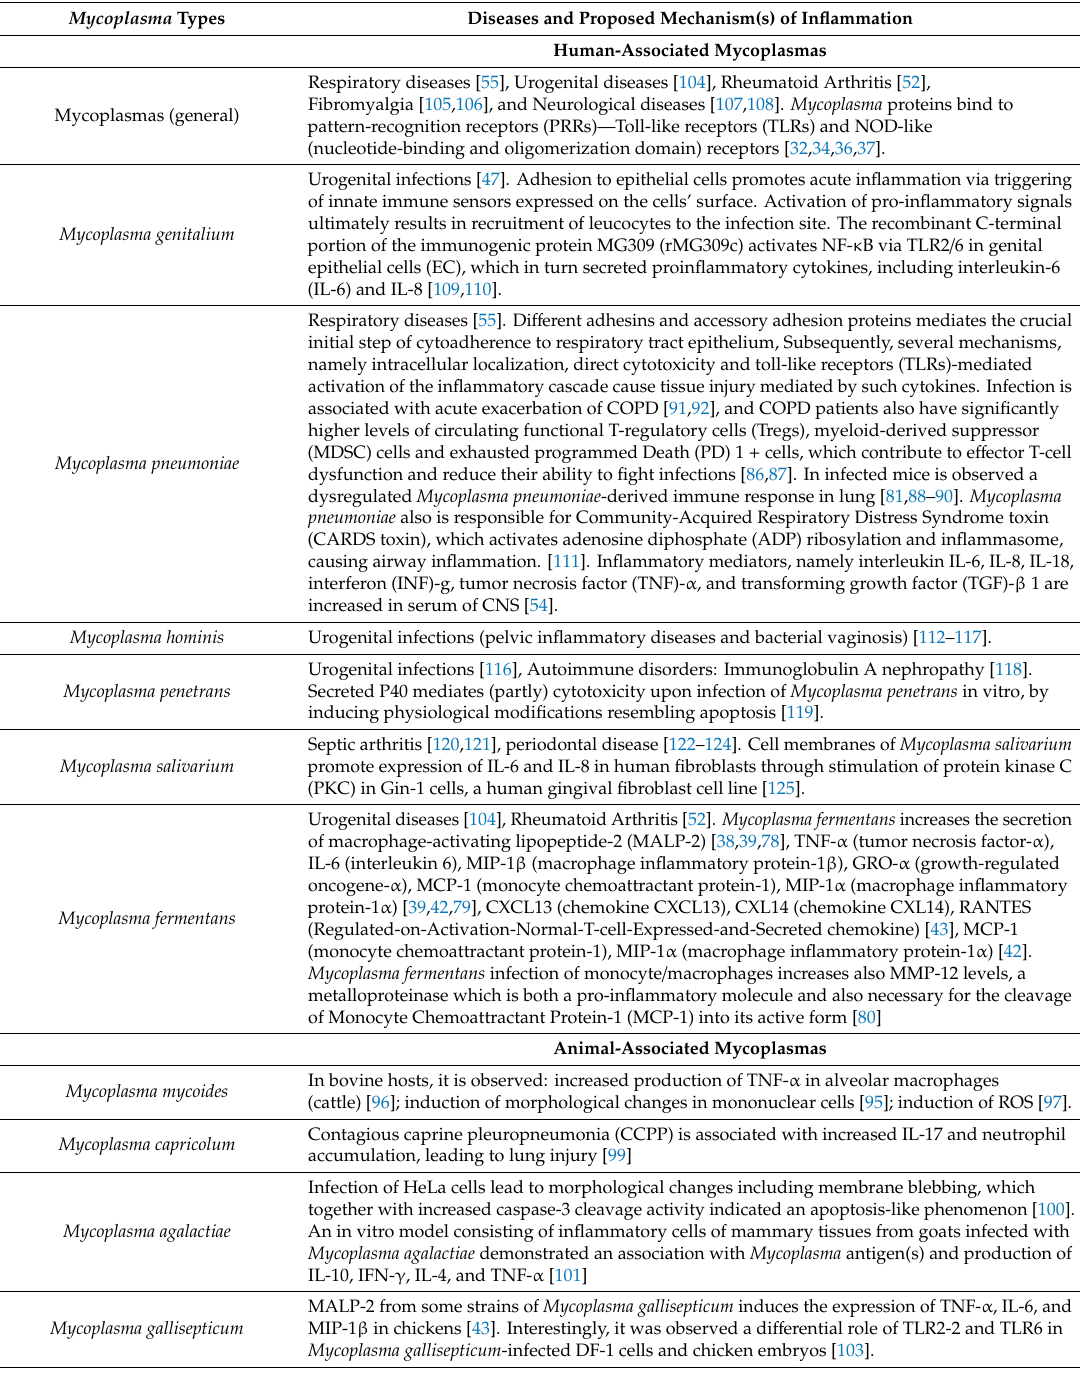
Table 1. Association between several species of Mycoplasma , diseases, and proposed mechanism(s) of